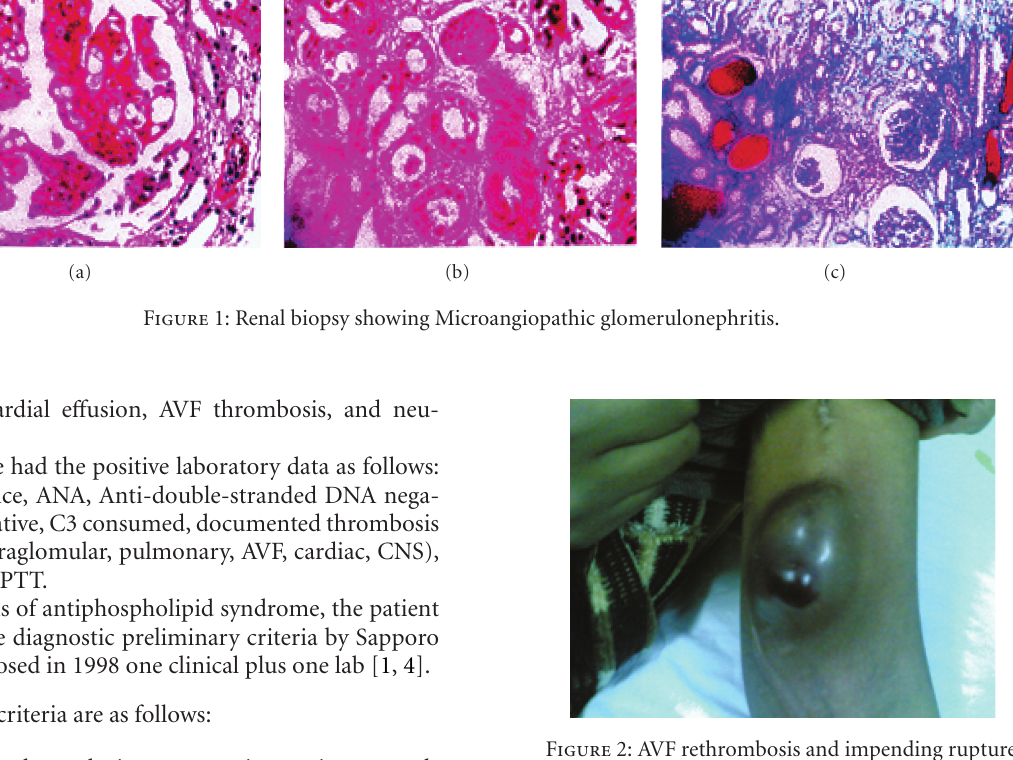
Figure 2: AVF rethrombosis and impending